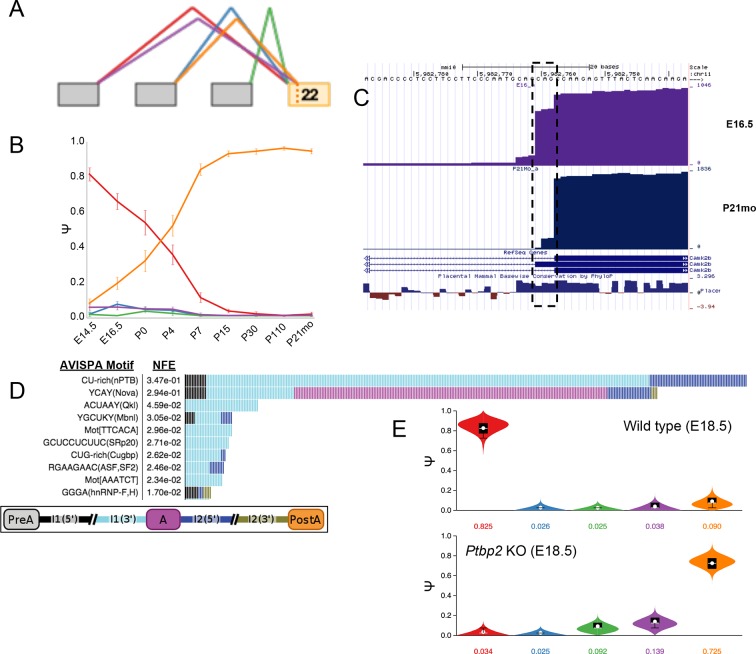
Developmentally controlled, complex LSV in Camk2b is
regulated by Ptbp2.(A) VOILA thumbnail representation of complex target LSV in
Camk2b detected from cortex development data
including a alternative transcription start in exon 21 (green junction)
that is not highly utilized and NAGNAG alternative 3’ splice sites of
reference exon 22. (B) Line graphs of MAJIQ Ψ quantification
(y-axis) of junctions as in (A) across time points (x-axis)
through cortex development show known increase in exon 20 inclusion
through development, coupled with a novel switch from proximal NAG 3’ss
(red) to almost exclusive use of distal NAG 3’ss (orange) by adulthood.
Points represent mean Ψ and error bars represent one standard deviation.
(C) UCSC genome browser view of mapped reads from cortex
of embryonic 16.5 mouse (top, purple) or postnatal 21-month mouse
(bottom, blue). Dashed box highlights nucleotides corresponding to
conserved NAGNAG alternative 3’ss that is developmentally regulated.
(D) Top regulatory motifs predicted by AVISPA to
influence the CNS splicing patterns of exon 20. Stacked bars represent
the normalized feature effect (NFE) for each motif. Colors indicate the
contribution of the corresponding motif in the region indicated in the
inset. (E) Violin plots representing MAJIQ Ψ for wild type
E18.5 mice (top) and Ptbp2 KO littermates (bottom) shows
embryonic Ptbp2 represses adult specific inclusion of exon 20, as
previously reported (Li et al.,
2014), in addition to the switch in NAGNAG 3’ splice site
use.